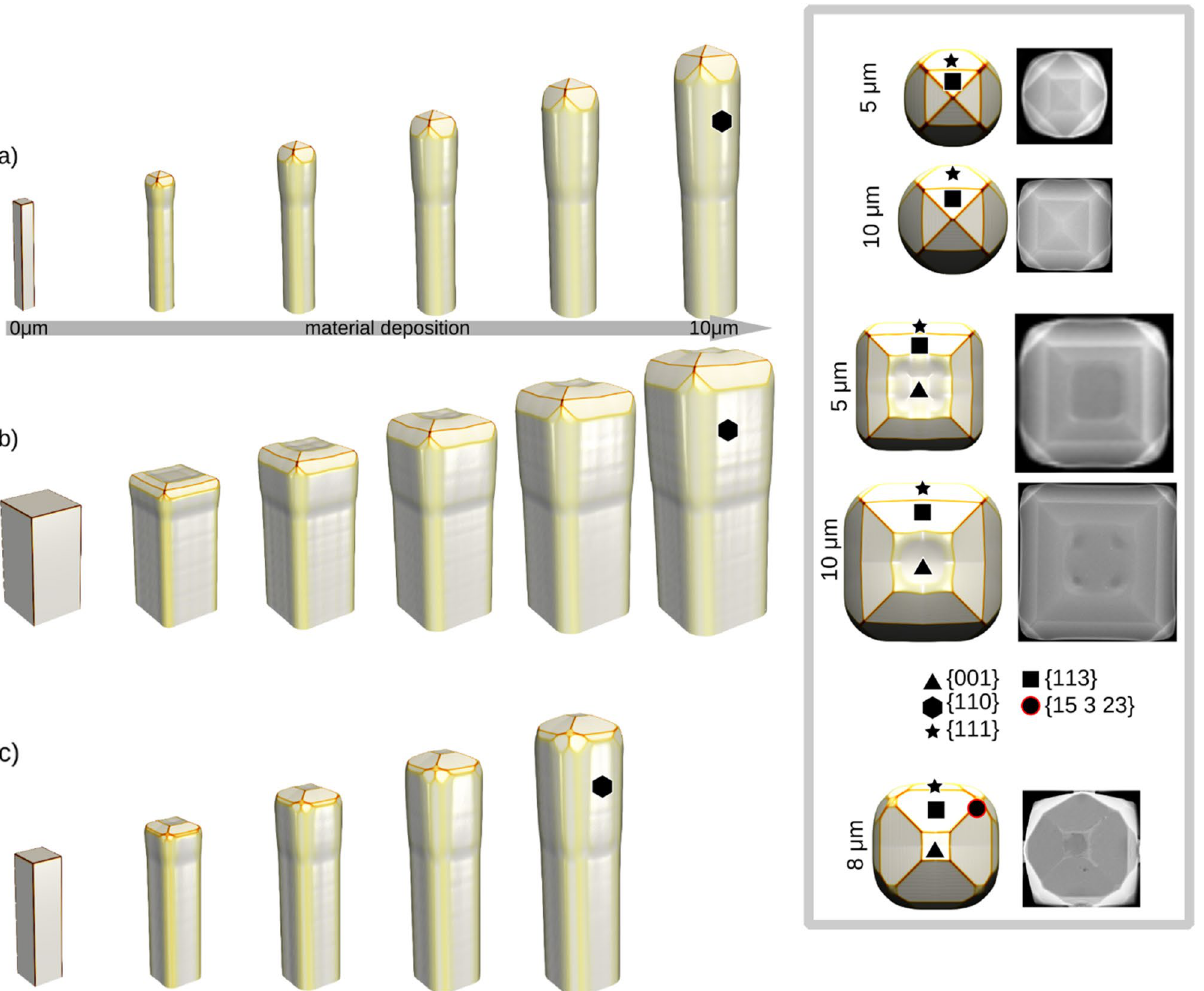
Figure 3. The simulation sequence fitted from the experiments. ( a ) Si deposited on Si pillar 1 × 1 μm, ( b ) Si deposited on Si pillar 4 × 4 μm and ( c ) Ge deposited on Si pillar 2 × 2 μm. On the right the corresponding top view is shown for specific material